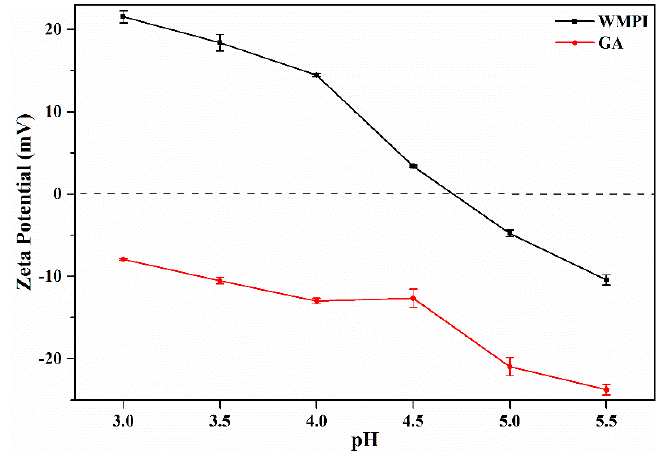
Figure 2. Effect of pH on zeta potential of WMPI and GA.